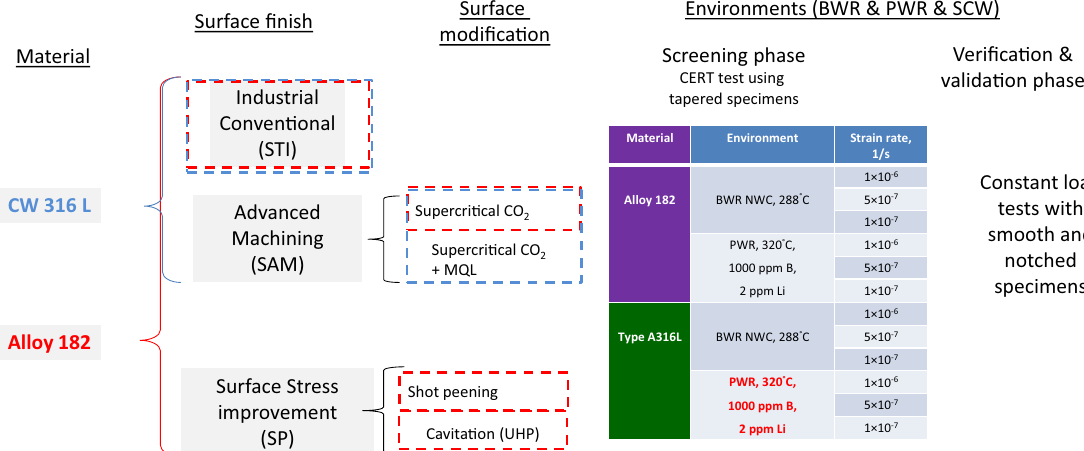
Fig. 2. Scheme of materials/test conditions carried out in the two experimental phases of the